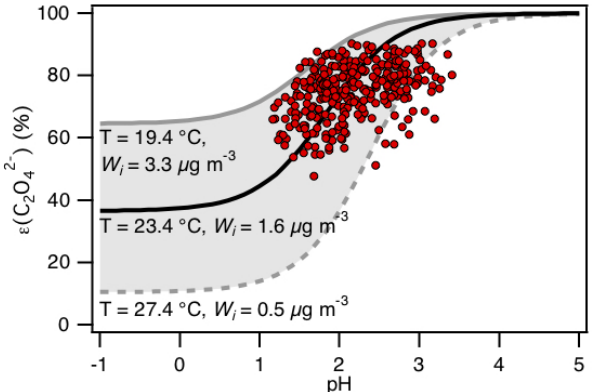
Figure 7. Analytically calculated S curve of ε (C 2 O 2 − ) and am- 4 bient data from 13 September to 6 October 2016 plotted against ISORROPIA-predicted particle pH. For the ambient data, a range in W i (0.5 to 4µgm − 3 ) and temperature (15 to 31 ◦ C) is chosen to be close to the analytically calculated outputs. For the analytically = 0 . 0492 (AIOMFAC pre- calculated S curves, we used γ C 2 H 2 O 4 = γ dicted). We also assumed that γ H + γ and used H + γ NO − C 2 HO − 4 3 = 0 . 265. The = q γ the ISORROPIA-predicted γ H + γ NO − H + − NO − 3 3 black line is the S curve calculated using the selected time period’s average temperature (23 . 4 ± 4 . 0 ◦ C) and W i (1 . 6 ± 1 . 7µgm − 3 ). The grey lines are S curves calculated using 1 standard deviation from the average temperature and W i (i.e., temperature = 27.4 ◦ C and W i = 0 . 5µgm − 3 for dotted grey line; temperature = 19.4 ◦ C and W i = 3 . 3µgm − 3 for solid grey